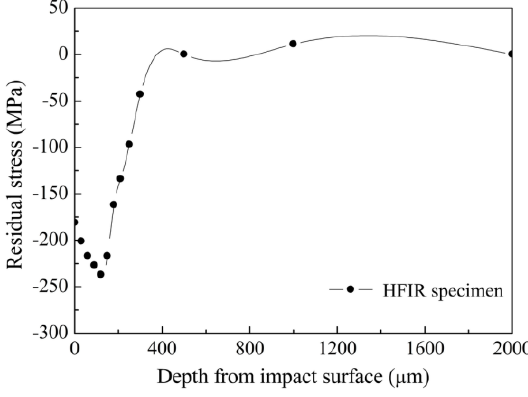
Figure 11. Residual stress distribution of the HFIR specimen.